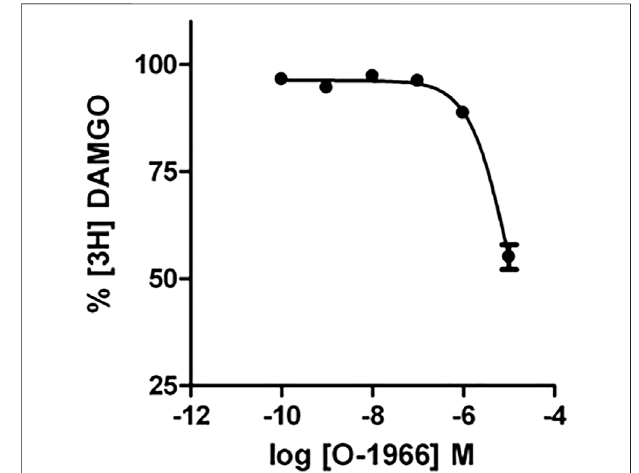
FIGURE 6 | Effect of increasing concentrations of O-1966 on [ 3 H] DAMGO binding. O-1966 has a low af fi nity for the rMOR. At a dose of 10 μ M, O-1966 inhibited ~50% of radiolabled [ 3 H]DAMGO (2 nM) to rMOR. Lower doses (0.1 nM – 1 µM) of O-1966 have no effect on [ 3 H]DAMGO binding to CHO-rMOR. Each data point represents the mean (±S.E.M.) from three independent experiments run in duplicate.